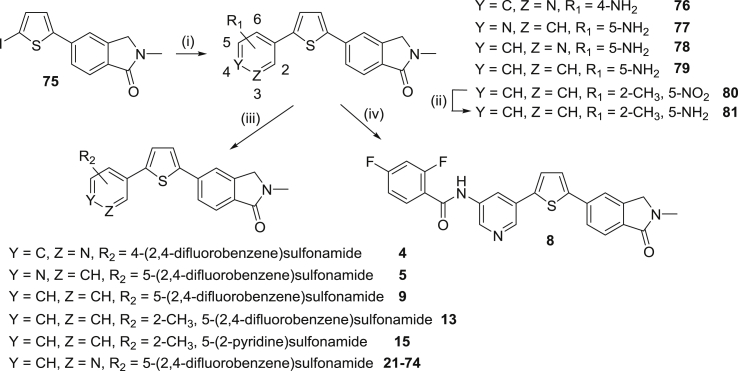
Reagents and conditions: (i) Boronate, Pd(dppf)Cl2, EtOH/toluene, 2 M Na2CO3, reflux; (ii) H2, 60 psi, 1:1:1 EtOH/EtOAc/THF, RT, 3 h; (iii) 2,4-Difluorobenzenesulfonyl chloride or pyridine-2-sulfonyl chloride, pyridine, 0–45 °C; (iv) 2,4-Difluorobenzenoic acid chloride, pyridine, 0–45 °C, 16 h.